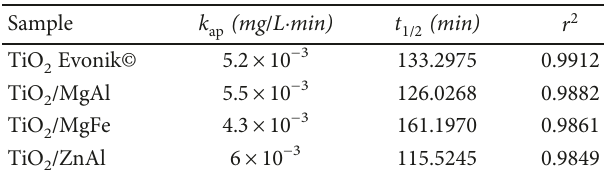
Figure 8: Pseudo- fi rst order kinetics for adjustment to model Langmuir-Hinshelwood. Table 3: Kinetic parameters obtained for Langmuir-Hinshelwood